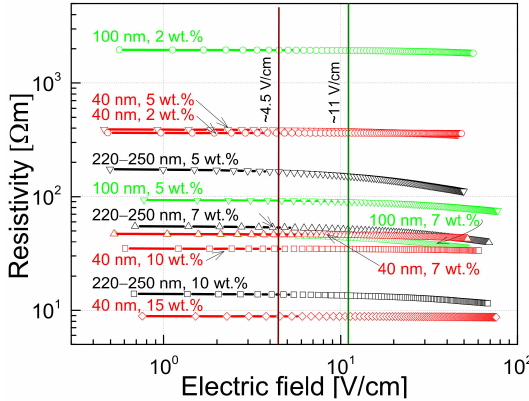
Figure 3. Dependences of the sample resistivity on the applied electric field at 290